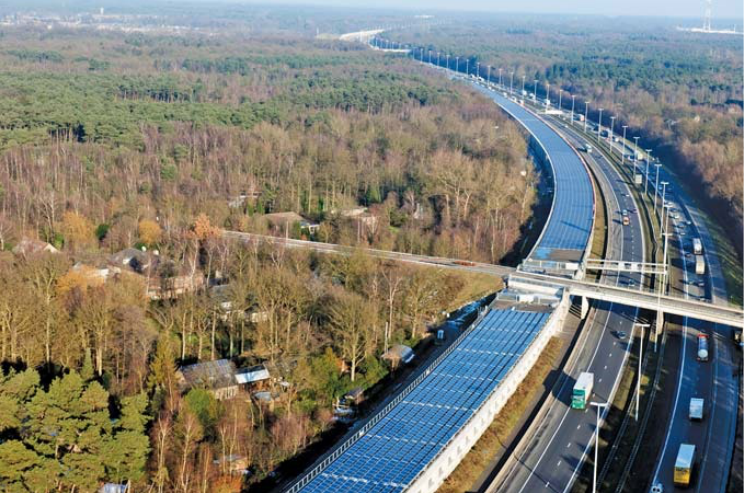
Figure 4. The Belgian solar tunnel [23].